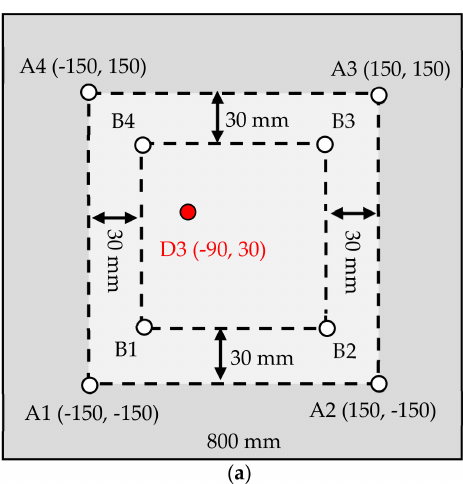
Figure 26. Experimental evaluation: ( a ) schematic diagram; ( b ) laboratory setup.